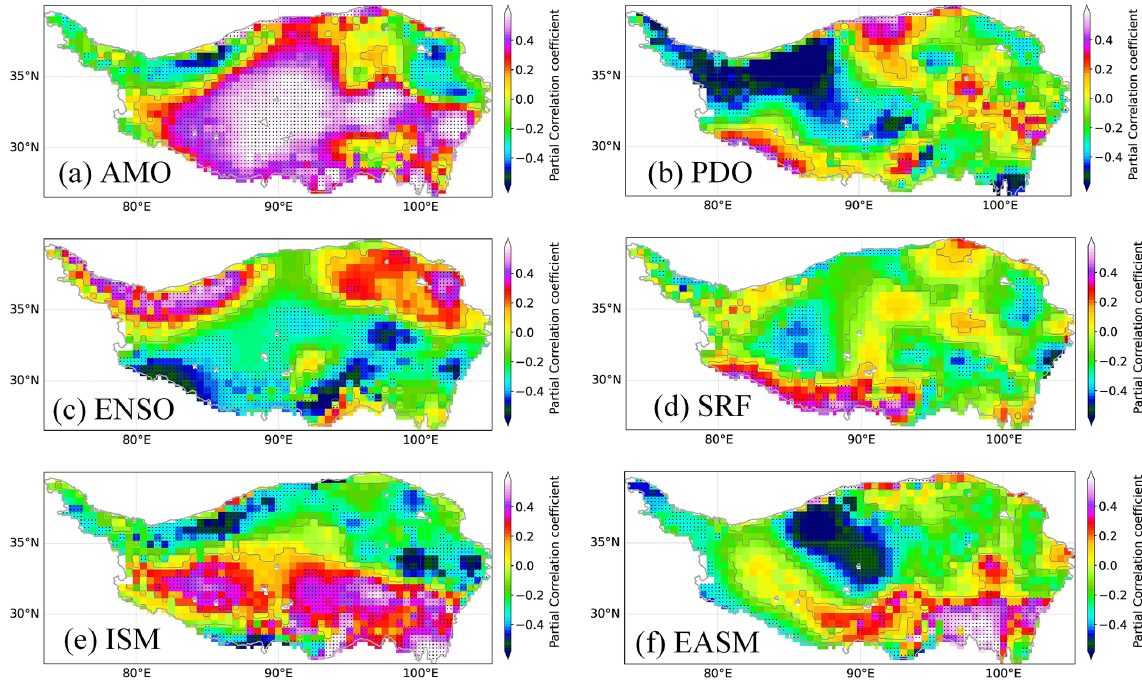
Figure 14. Spatial distribution of the partial correlation coefficients between the precipitation and the (a) AMO, (b) PDO, (c) ENSO (Niño